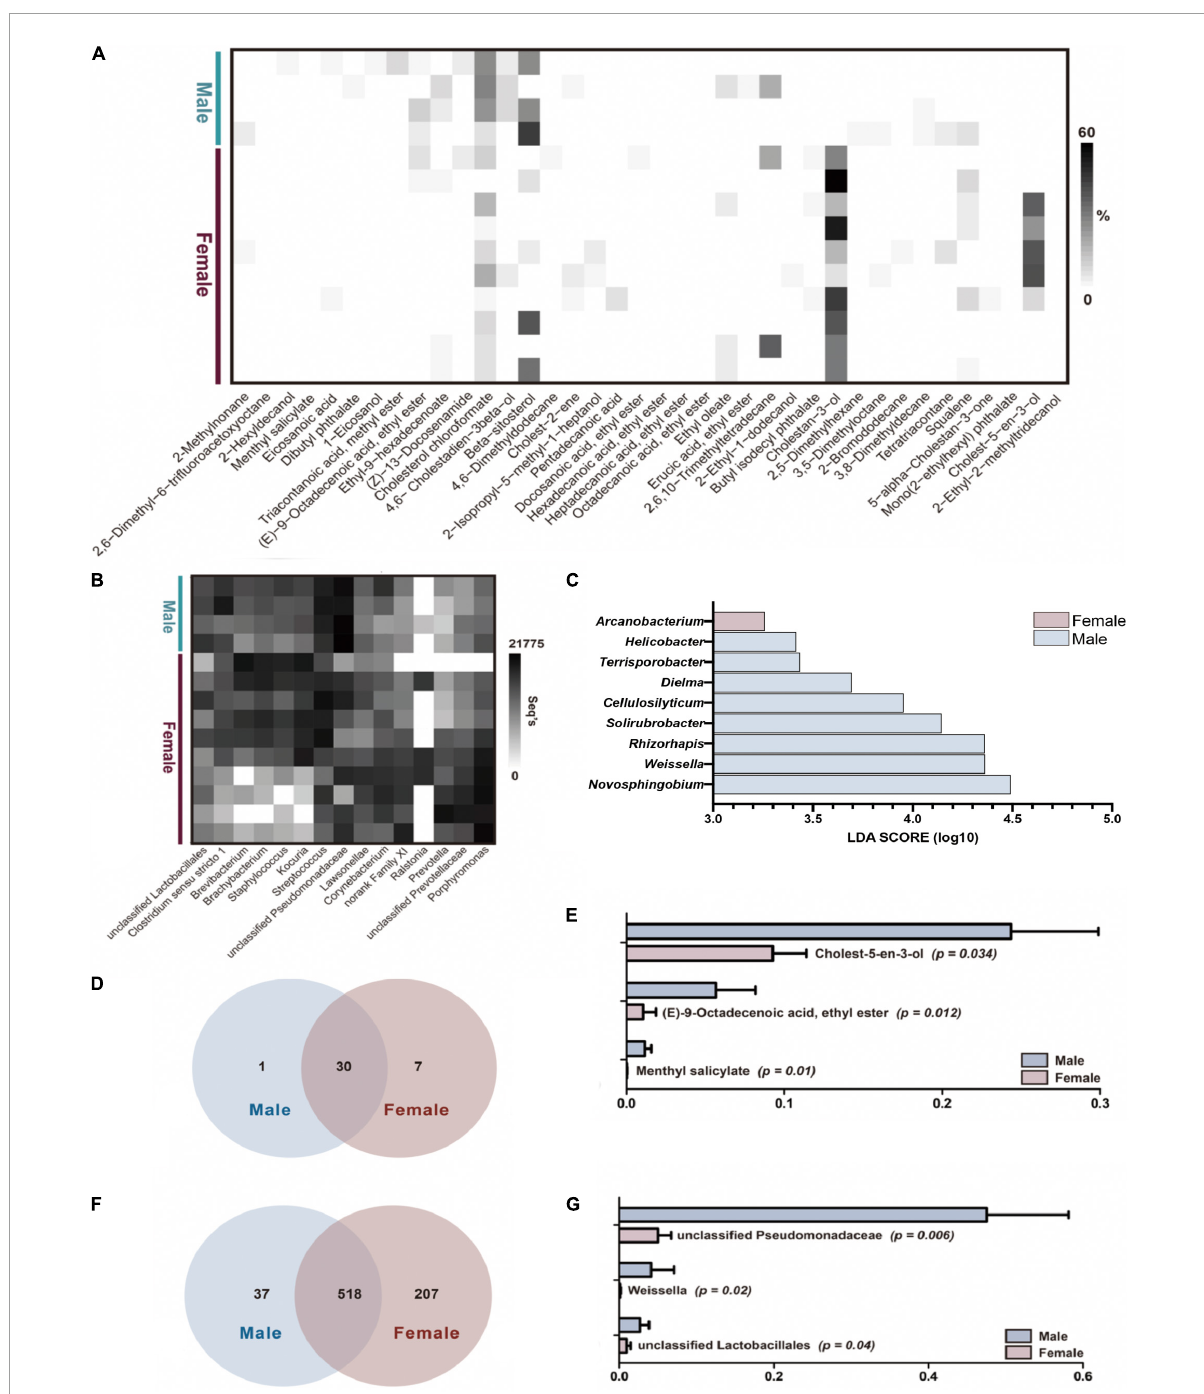
FIGURE2 The difference of bacterial and compounds’ profiles between male and female pandas AGS samples. (A) The odor core compounds abundance heatmap of AGS between male and female pandas during estrus ( n = 14). (B) The top 15 microbiota community abundance heatmap on genus level of AGS between male and female pandas during estrus ( n = 14). (C) The Liner Discriminant Analysis (LOA) analysis of AGS bacterial profiles between male and female pandas during estrus (The graph shows the LOA scores obtained from linear regression analysis of the significant microorganism groups in the two groups. When the default LOA value is more than 2 and the p value is less than 0.05, the result corresponds to a different species, n = 14). (D) The unique and shared compounds between male and female giant pandas during estrus in AGS core compounds ( n = 14). (E) The significant difference of AGS core compounds between male and female giant. pandas during estrus ( n = 14). (F) The unique and shared OTUs between male and female giant pandas during estrus ( n = 14). (G) The significant difference of AGM top 20 bacteria on genus level between male and female giant pandas during estrus ( n =